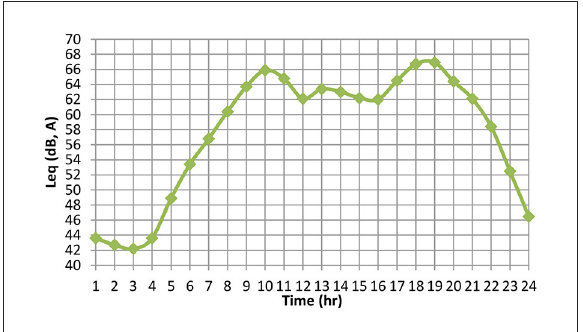
FIGURE10 Average hourly variation of noise level at silent